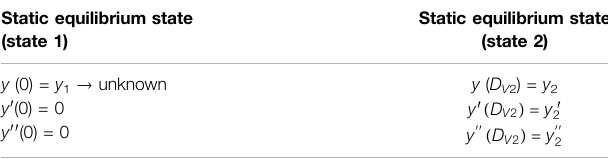
TABLE 4 | Preshake subphase conditions (vertical movement). Static equilibrium state (state 1)